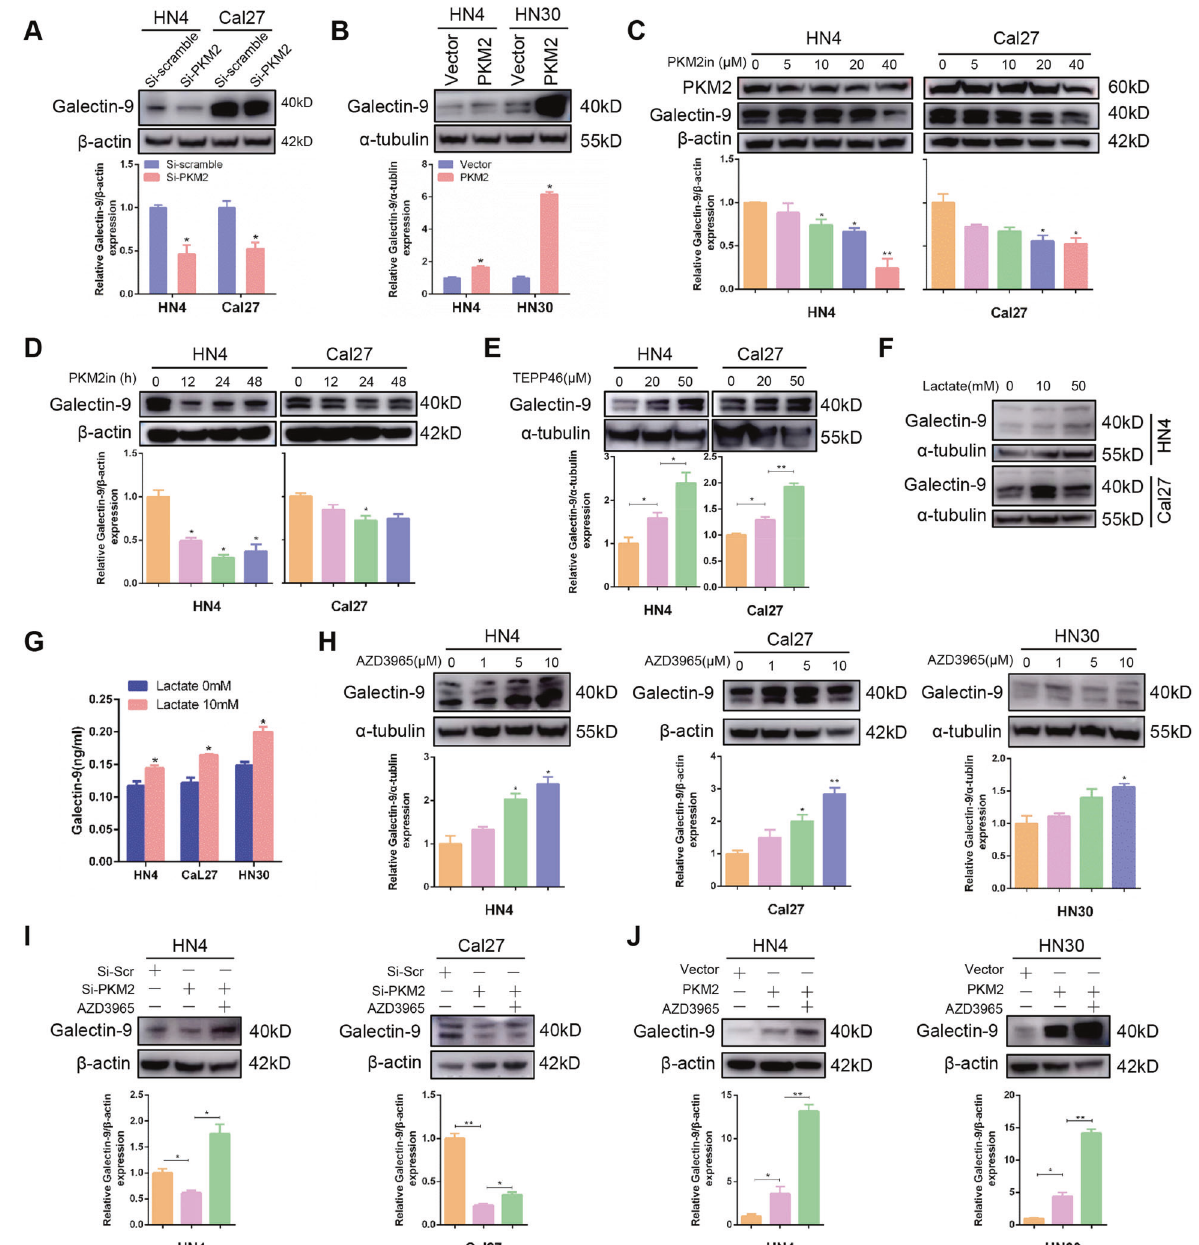
Fig. 5 PKM2 promotes Galectin-9-mediated immunosuppression through lactate secretion. A Galectin-9 expression was detected after PKM2-speci fi c siRNA transfection in HN4 and Cal27 cells for 48 h. B Galectin-9 expression was detected after transfection with PKM2 expressing plasmid transfection for 48 h. C Galectin-9 expression was detected after treatment with Compound 3K, a PKM2 inhibitor, at the indicated doses for 24 h. D Galectin-9 expression was detected after 40 μ M Compound 3K treatment at the indicated times. E Galectin-9 expression was detected after treatment with TEPP46, a PKM2 activator, at the indicated doses for 24 h. F After lactate stimulation for 24 h, Galectin-9 expression was detected using western blot. G Galectin-9 concentration in medium supernatant after 10 mM lactate treatment for 24 h was detected using ELISA. H Galectin-9 was assessed after treatment with the indicated dose of AZD3965, a MCT1 inhibitor, for 24 h. I , J Galectin-9 was detected using western blot after PKM2 transfection for 24 h and then 10 μ M AZD3965 treatment for 24 h. * P < 0.05, ** P <